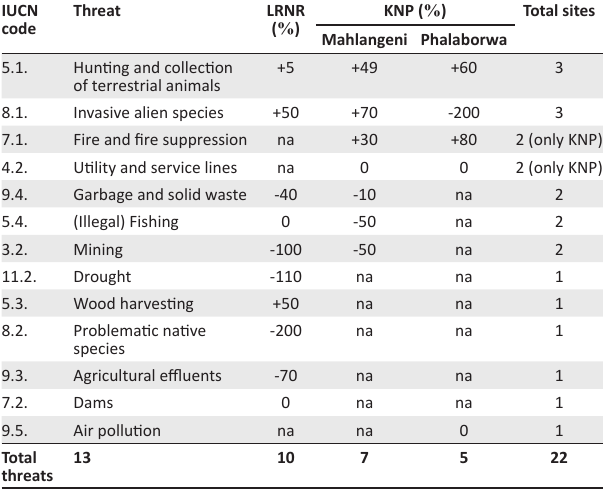
TABLE 1: Identified threats to biodiversity and percent mitigation from 2013 to 2017 in the Letaba Ranch Nature Reserve, and Mahlangeni and Phalaborwa sections of the Kruger National